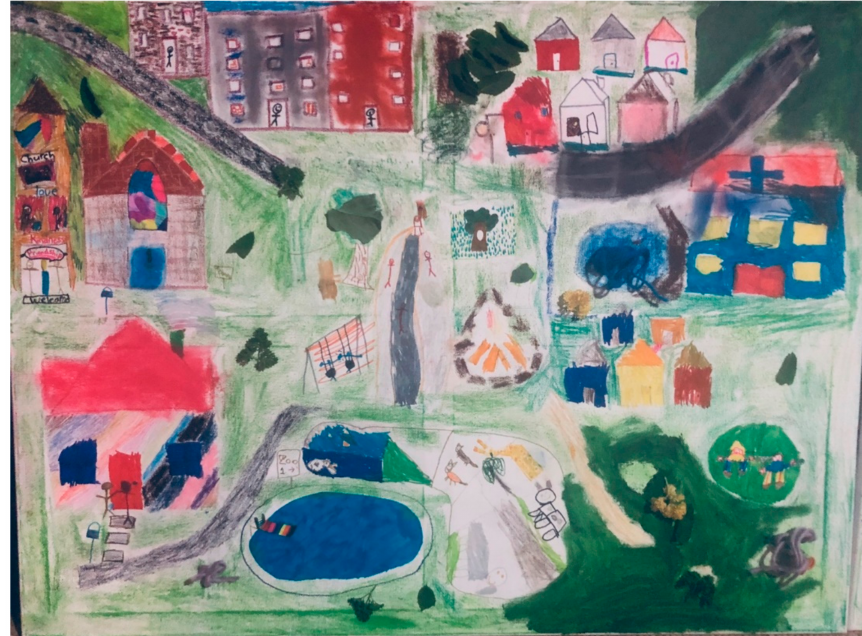
Figure 4. Future city, example from an Australian church youth group, 2018. This image features a community pool, a zoo, a campfire, a large playground, a church with stained glass windows, a hospital and a number of houses. RMIT University Human Ethics Clearance Number